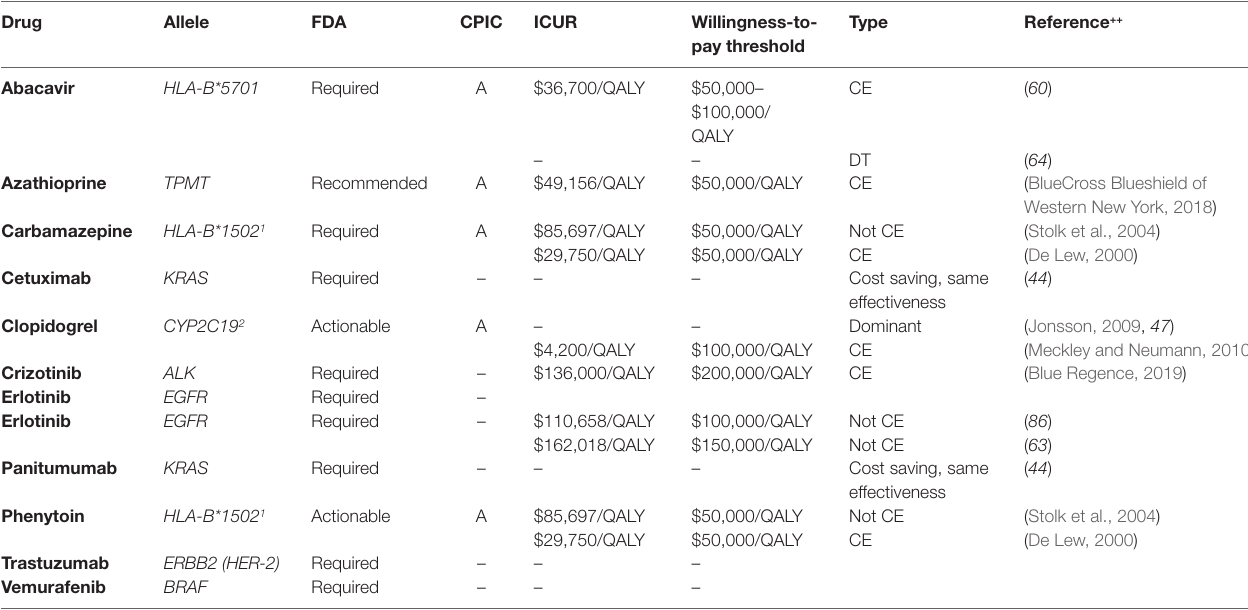
TABLE 2 | Pharmacogenomic tests covered by